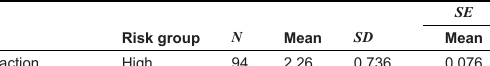
TABLE 9 Group statistics: Job satisfaction